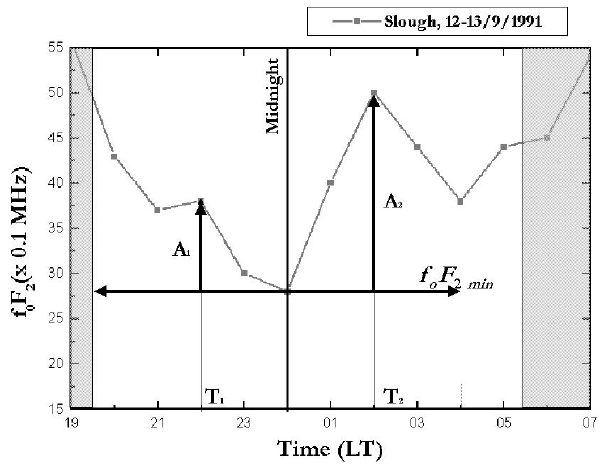
Fig. 1. Definition of each of the two peaks and their characteristic parameters from the original fo F2 data. Shadowed rectangles show sunlit